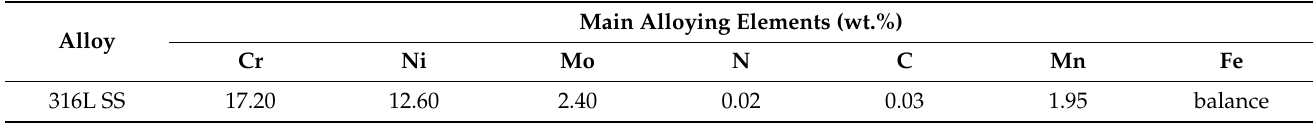
Table 1. Composition of utilized 316L SS specimens. Main Alloying Elements Alloy